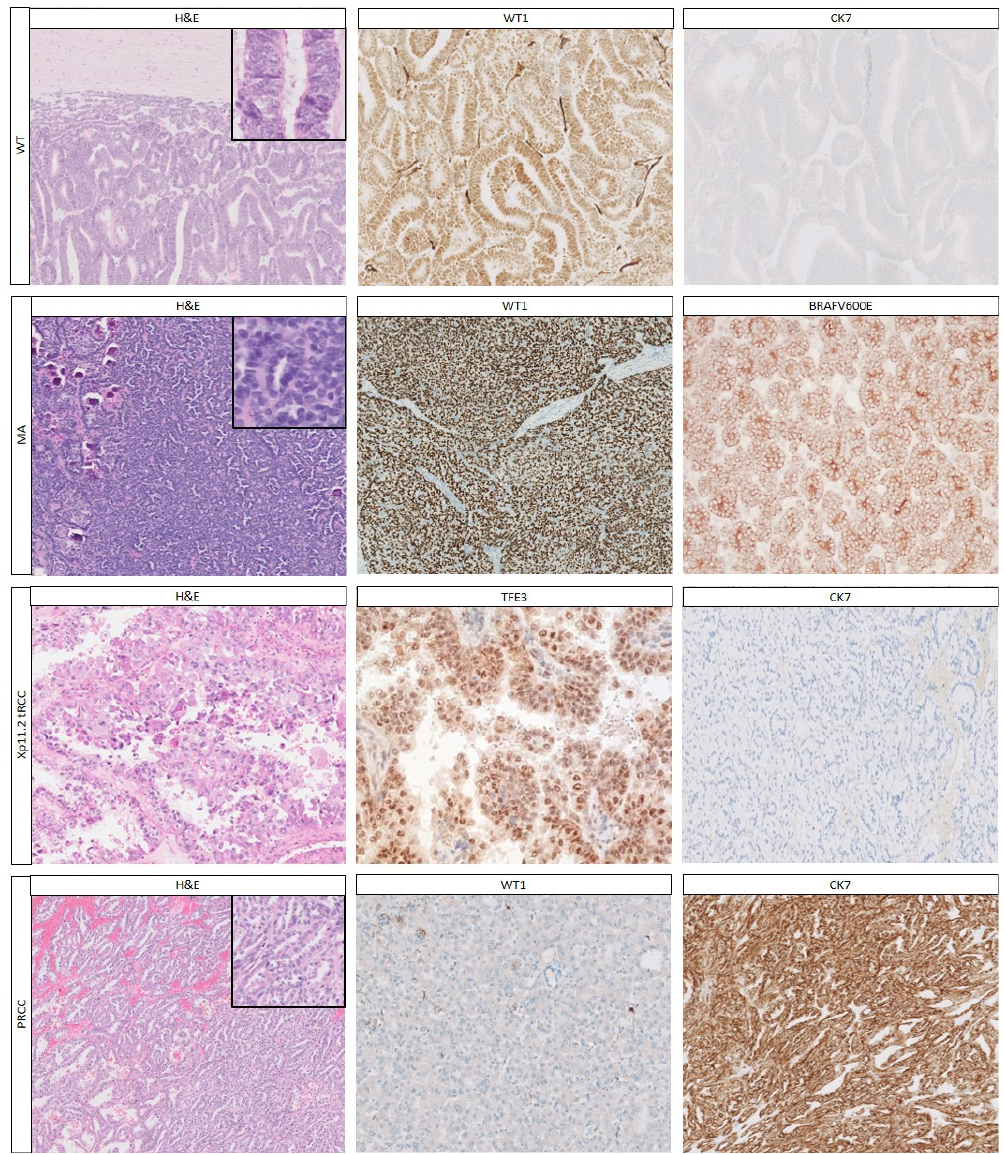
Figure 1. The most common pediatric renal tumors with an epithelial pattern and their most important immunohistochemical staining. Epithelial Wilms tumor (WT) showing epithelial structures which shows characteristic strong nuclear staining for WT1 as well as lack of staining for CK7. The classical histology of metanephric adenoma (MA) consists of closely packed mature tubules and papillary structures as well as psammoma calcifications, which shows strong nuclear staining for WT1, but also strong staining for BRAFV600E corresponding to the BRAF mutation present in ~80–90% of MAs. Xp11.2 translocation renal cell carcinomas (tRCCs) typically show large epithelioid cells with copious amounts of eosinophilic cytoplasm and a large eosinophilic nucleolus; these tumors show nuclear TFE3 staining and most cases show absent or decreased staining for cytokeratins, such as the negative cytokeratin 7 (CK7) shown here. Papillary renal cell carcinoma (PRCC) with typical papillary structures, often with rather small monotonous nuclei, with lack of reactivity to WT1, but strong staining for CK7. H&E and immunohistochemical stainings at 10× magnification; inset at 40× magnification.